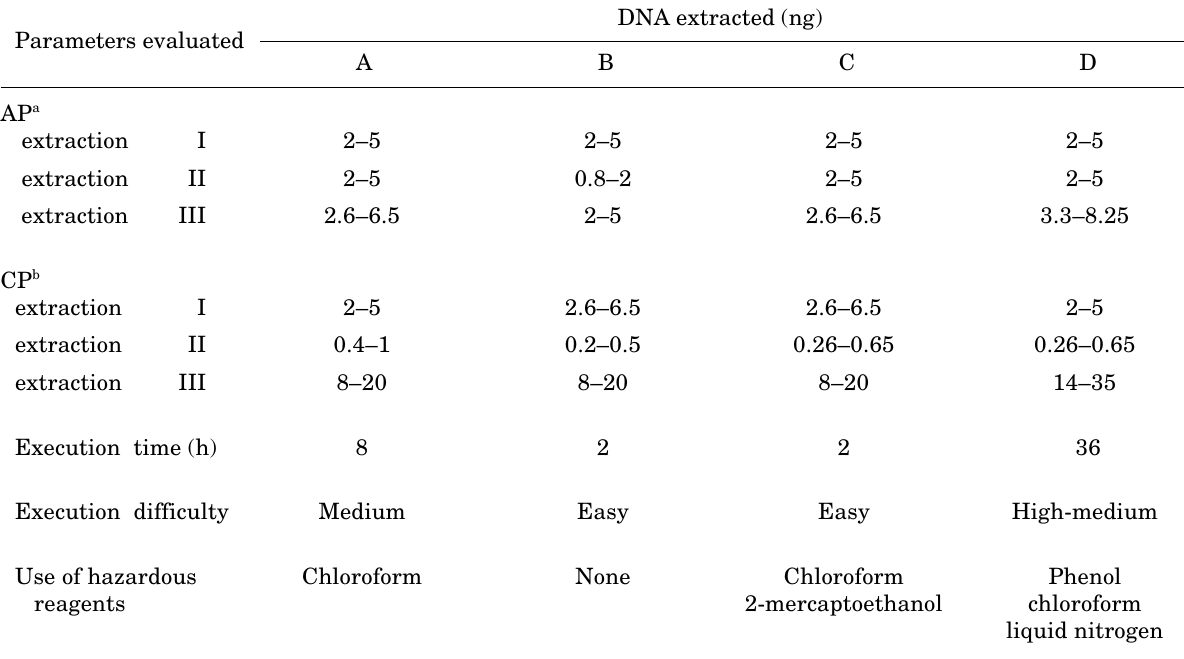
Table 1. Summary of the four methods evaluated in this work. Each column corresponds to one of the DNA extraction methods, designated A, B, C, and D. In the first and second row are shown the estimated amounts of AP- and CP- phytoplasma DNA obtained in the three series of extraction for each method and expressed as ng. In the other rows are shown some parameters which characterise the four extraction techniques: execution time, difficulty and use of dangerous